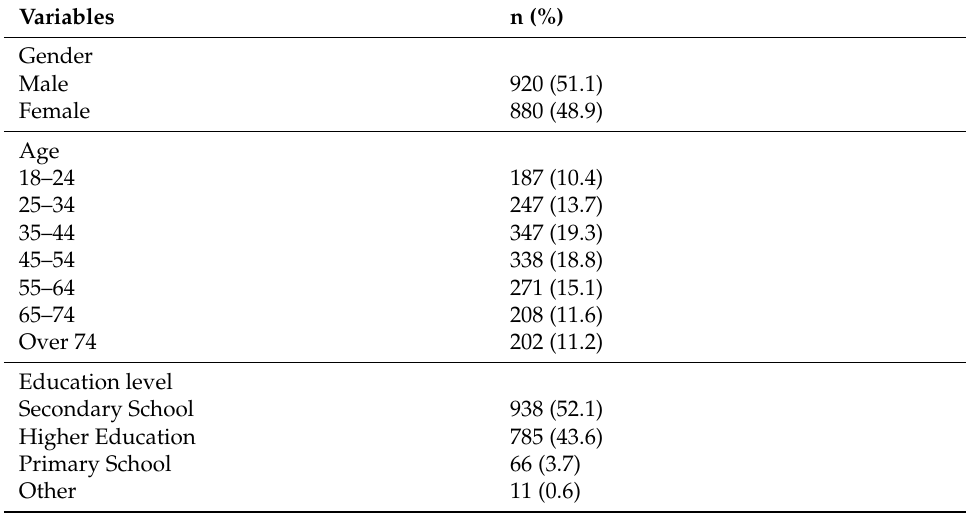
Table 1. Sociodemographic characteristics of the